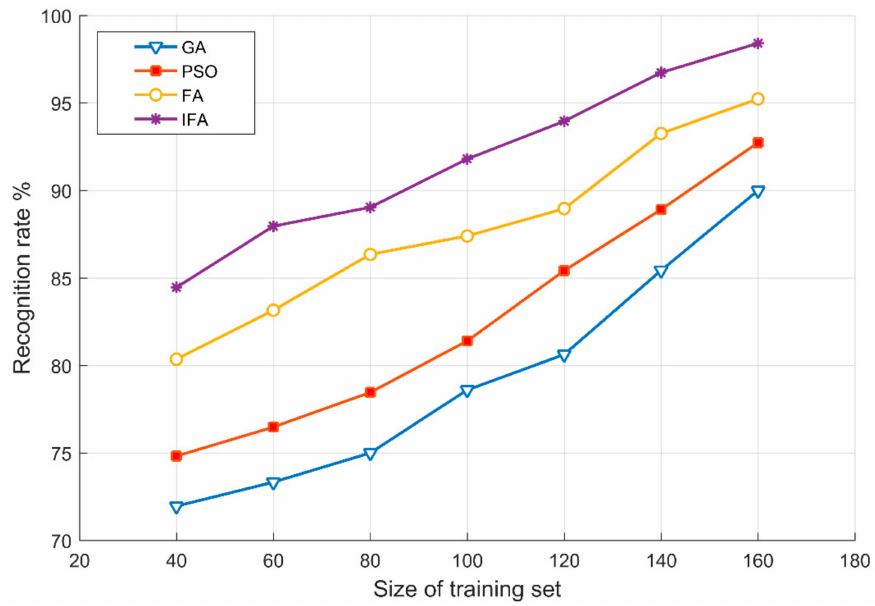
Figure 8. Comparison of the IFA with other methods in the fourth case